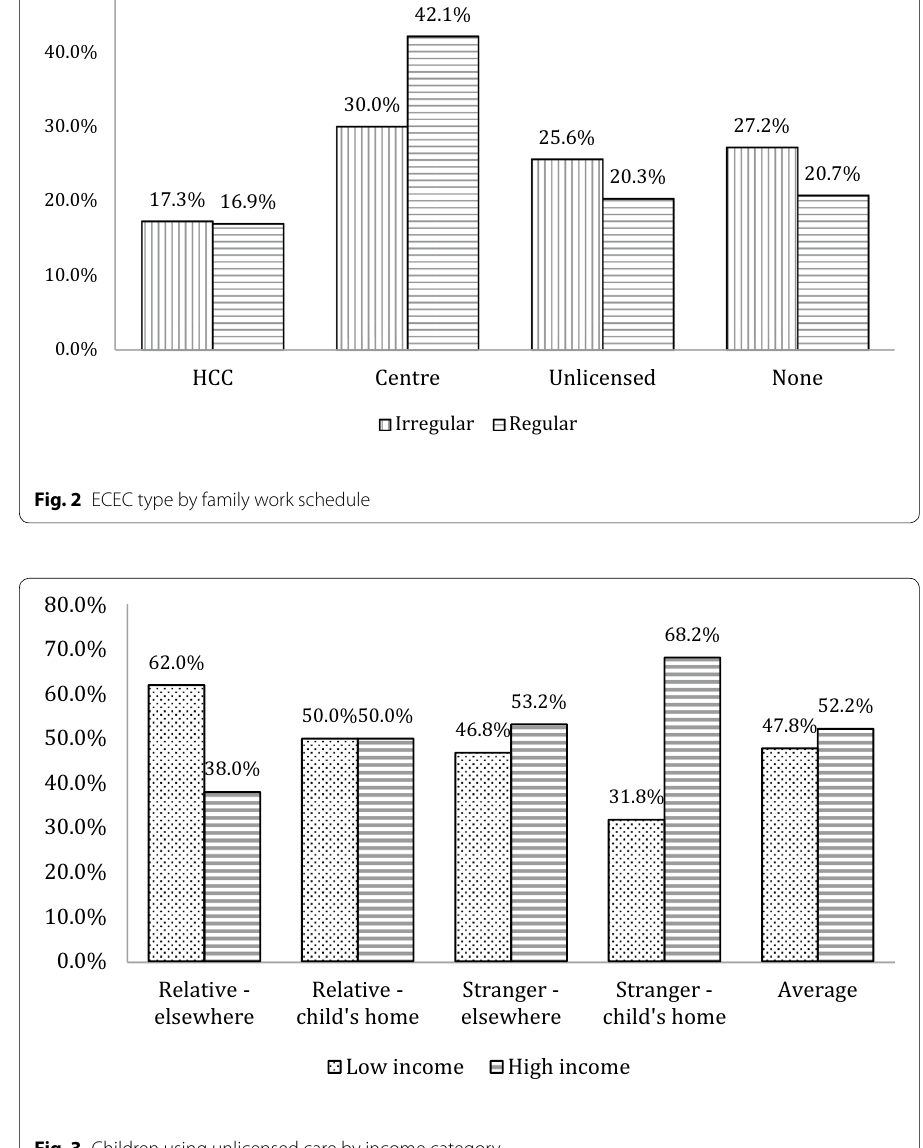
Fig. 3 Children using unlicensed care by income